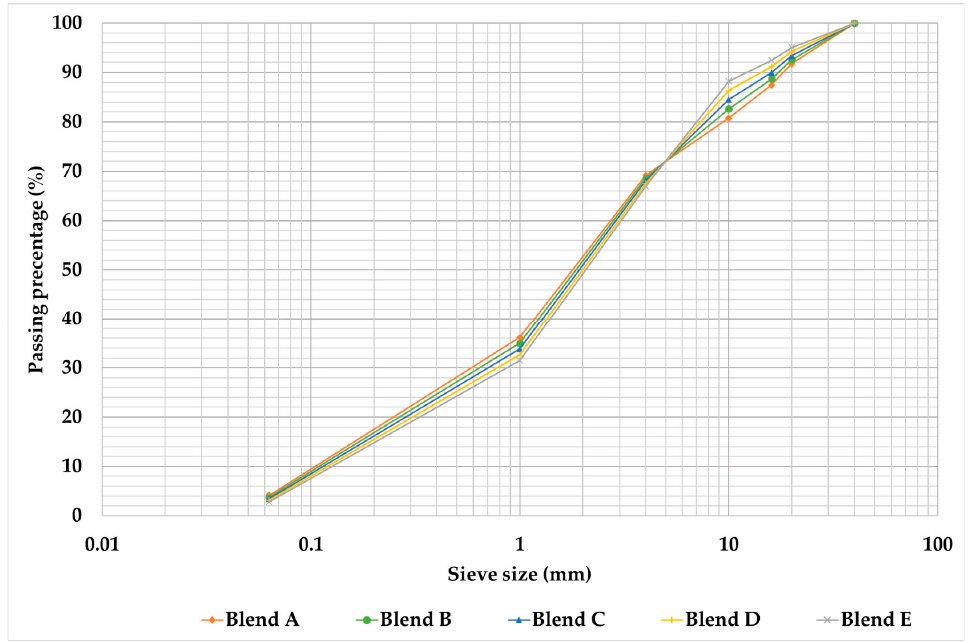
Figure 4. Grain size distribution of all examined blends.